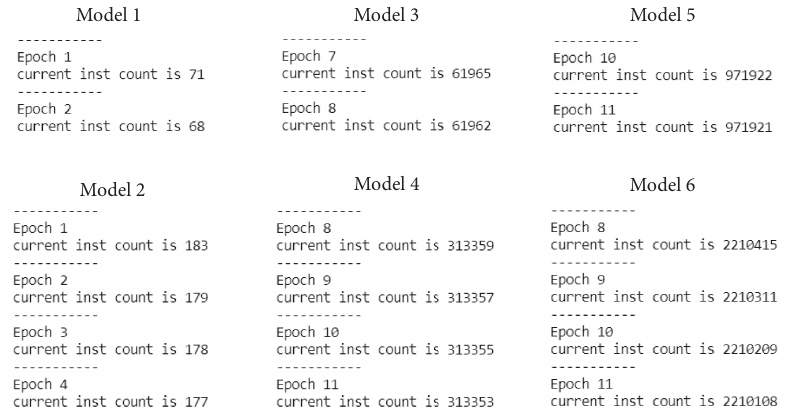
Figure 7: A demonstration of the epoch cost of each test model in this research (detailed information of each model will be discussed in Section 4).